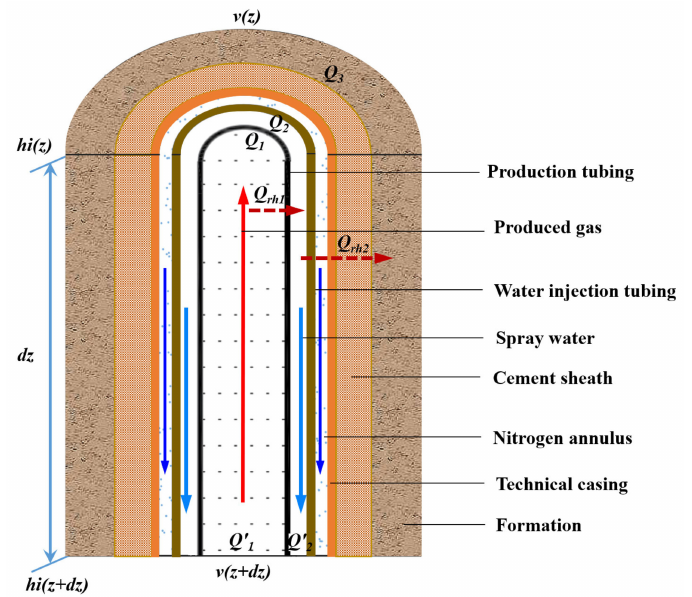
Figure 6. Calculation model of water injection spray temperature field in concentric